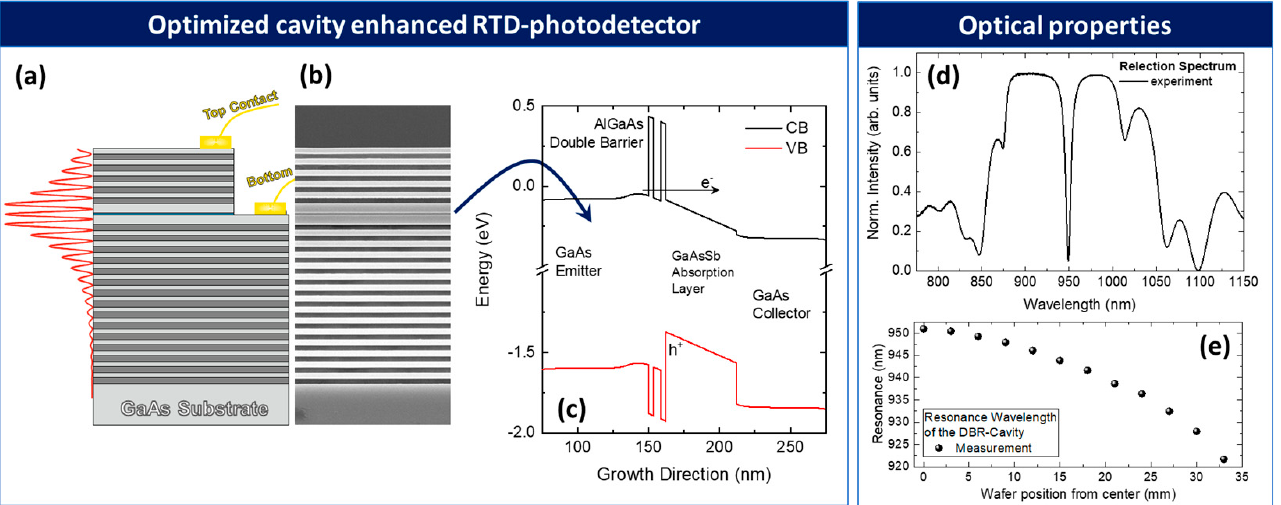
Figure 7. ( a ) Layer structure of the cavity-enhanced RTD photodetector. The RTD-SPD is integrated in an optical resonator formed of five top and fifteen bottom DBR mirror pairs. The GaAsSb absorption layer (shown in blue) is placed at the center of the cavity in the optical field maximum to ensure optimal absorbance. ( b ) Cross-sectional SEM image with dark contrast regions corresponding to the Al-rich containing layer. ( c ) Calculated conduction and valence band profile of the RTD photodetector with GaAsSb absorber. ( d ) Experimentally measured reflectivity. The resonance wavelength is at 950 nm. ( e ) Wafer position-dependent resonance wavelength measured from the center of the 3-inch wafer to the edge. A shift of the resonance wavelength of about ∆ λ = 30 nm can be achieved. Figure 7b shows the cross-sectional scanning electron microscopy (SEM) image of the cavity-enhanced photodetection system with dark contrast regions corresponding to Al-rich layers and Figure 7c shows the calculated conduction and valence band profile of an RTD photodetector with GaAsSb absorber region. Figure 7d shows the experimentally measured reflectivity spectrum of the cavity-enhanced RTD photodetector. The resonance wavelength is at 950 nm. The reflection dip at resonance drops to below 10%, which indicates the almost ideal critical coupling conditions under which quantum efficiencies above 90% can be reached. Figure 7e shows resonance wavelength as a function of the wafer position from the center of the 3-inch wafer to the edge. The semiconductor growth rate of the molecular beam epitaxy chamber decreases from the center to the edge, causing a pronounced blue shift of about ∆ λ = 30 nm. The DBR cavity-enhanced RTD photodetector can readily be fabricated in ring-contact geometry. Figure 8 shows a tilted-angle cross-sectional SEM image. The top DBR mirror is doped, whereas the bottom DBR mirror is left undoped to reduce loss. As a result, the bottom contact is applied as intra-cavity contact. The optical microscopy image in Figure 8 shows the surface of the sample. The circular ring contact is clearly visible. To prevent the ring contact from forming a short circuit with the bottom part of the cavity, the sample surface and mesa-sidewalls were passivated with SiO 2 . The passivation was removed where the bottom intra-cavity contact was applied. The oxide-open areas beneath the bottom contact are clearly visible from the optical microscopy